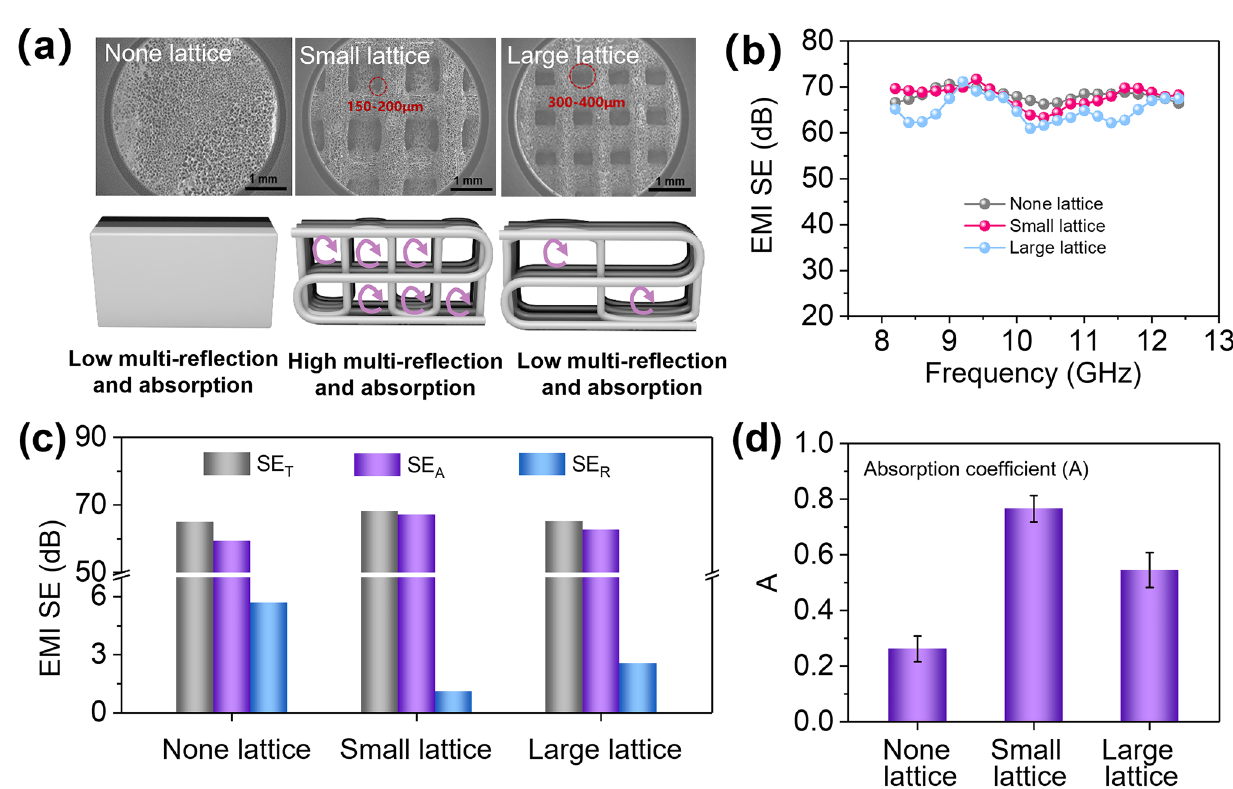
Fig. 4 Electromagnetic shielding performance of GCMCP aerogel frames with different lattice size, thickness: about 5 mm. ( a ) SEM images and EMI shielding mechanism of GCMCP aerogel frames with different lattice size. ( b ) EMI SE , ( c ) SE T , SE A and SE R value and ( d ) absorption coefficient of none lattice, small lattice (150–200 μm) and large lattice (300–400 μm),